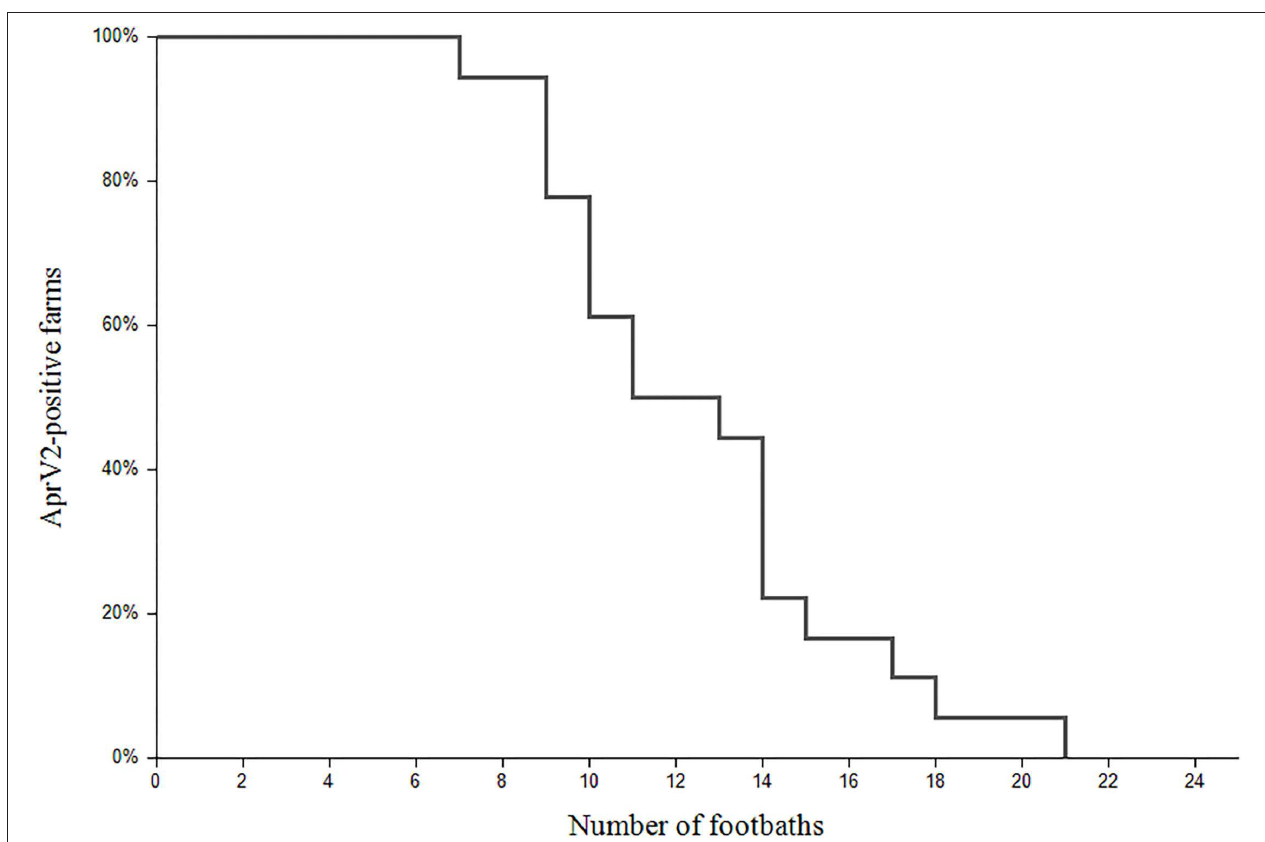
FIGURE 2 | Survival plot of the aprV2 -positive status during the treatment of footrot in 18 flocks. The x -axis refers to the number of footbaths and the y -axis represents the percentage of the farms (%) with aprV2 -positive status.